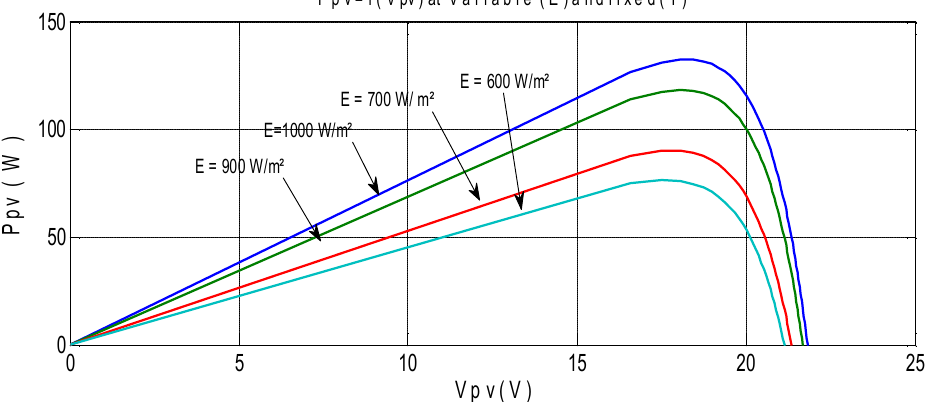
Figure 3. Variation of the photovoltaic generator (GPV) power and voltage, for different values of the illumination at a fixed temperature.